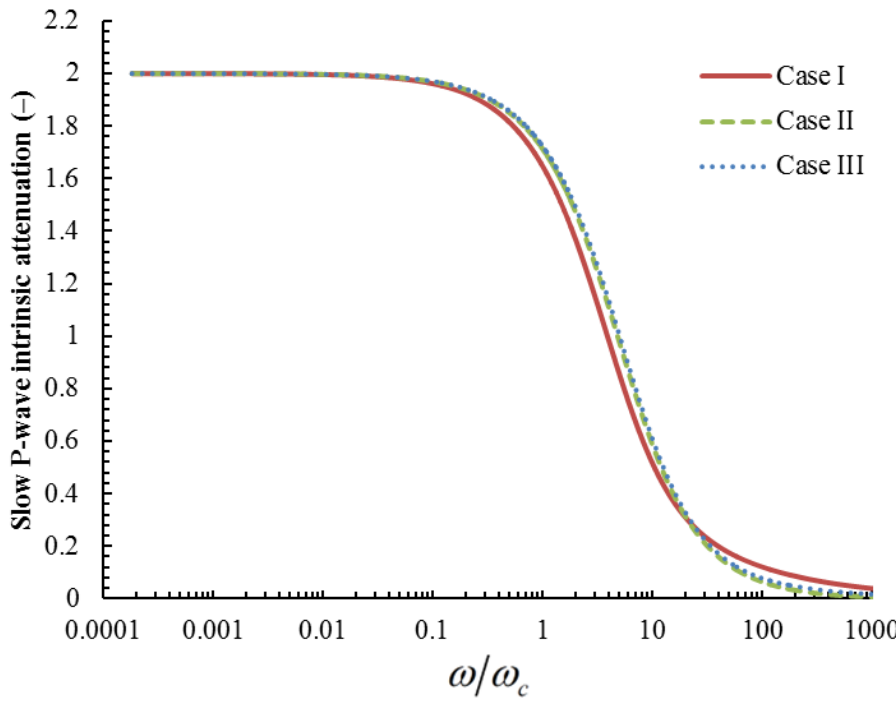
Fig. 5. Slow wave intrinsic attenuation versus dimensionless 229